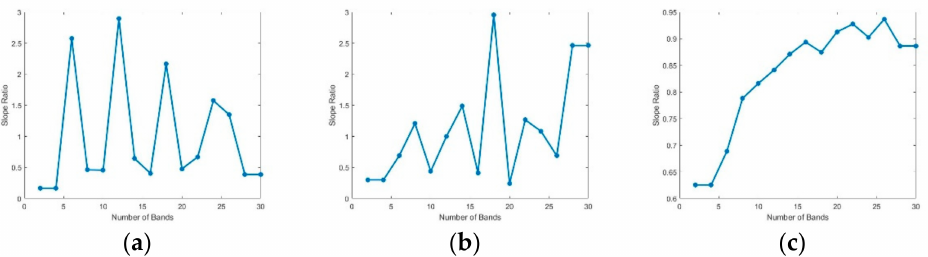
Figure 10. Slope rate of information redundancy ( a ) Indian Pines data set ( b ) Salinas data set ( c ) Botswana data